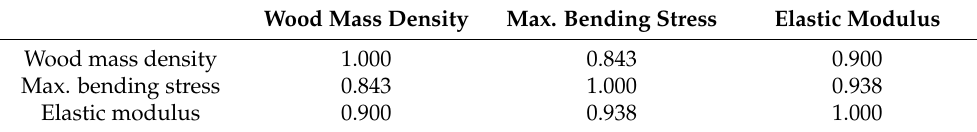
Table 3. Correlations between the density, the bending strength and the elastic modulus. Wood Mass Density Max. Bending Stress Elastic Modulus Wood mass density 1.000 0.843 0.900 Max. bending stress 0.843 1.000 0.938 Elastic modulus 0.900 0.938 1.000